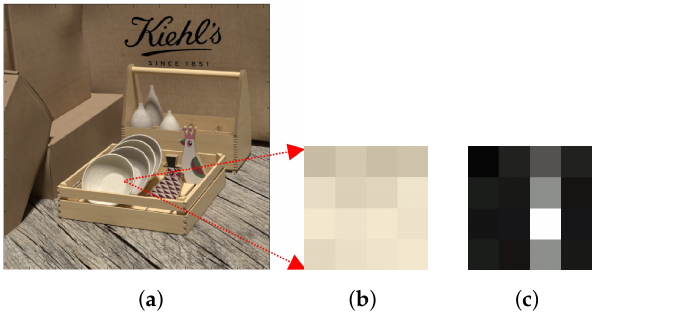
Figure 10. ( a ) Central sub-aperture image of a LF image, ( b ) a magnified 6 × 6 RGB image patch and ( c ) FFT of the image patch.